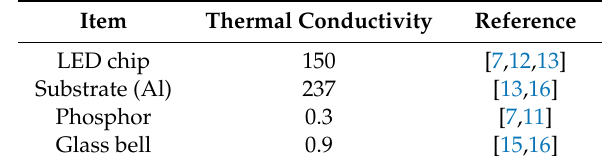
Figure 5. Mesh of the numerical simulation model.